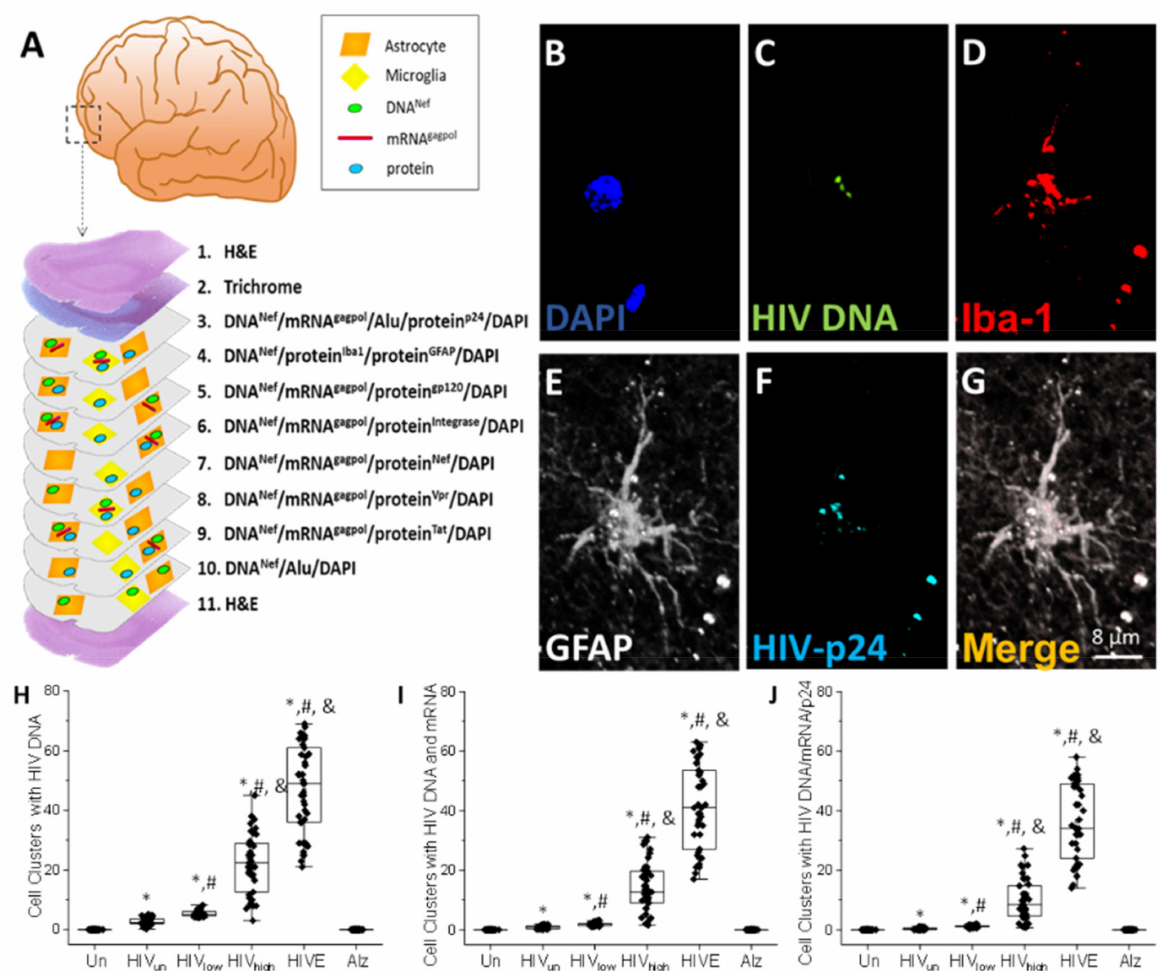
Figure 1. HIV reservoirs are organized in small clusters within the brain of HIV-infected individu- als. ( A ) The image shows the detection strategy for HIV DNA, viral mRNA, and viral proteins, as